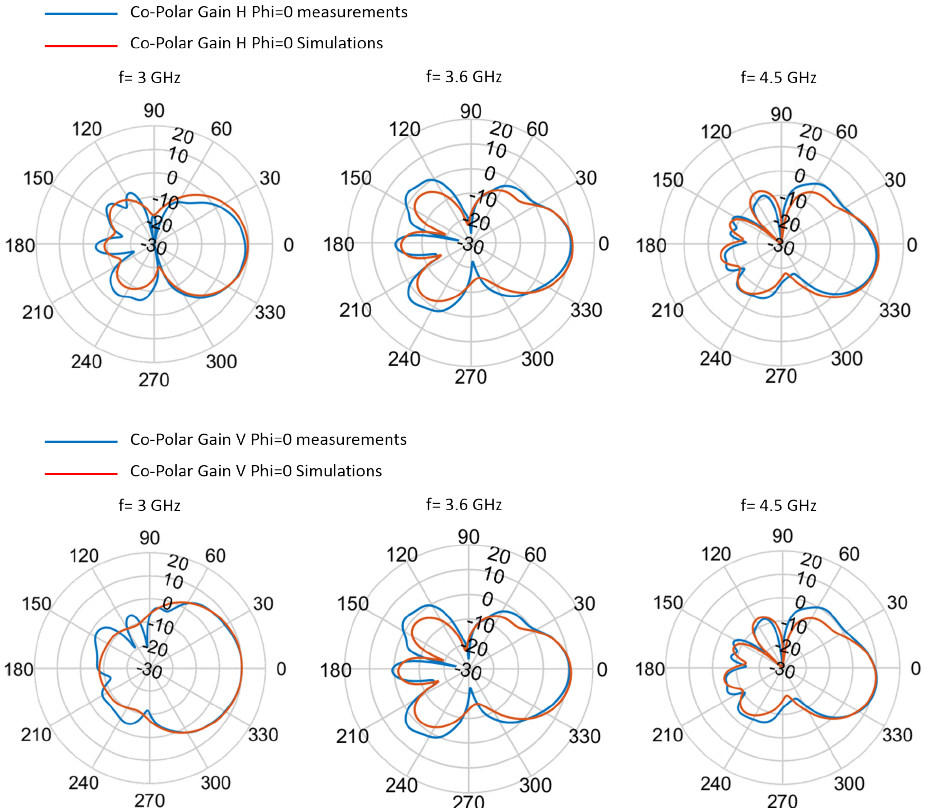
Figure 12. Scaled prototype: comparison between measurement and simulation in term of co-polar and cross-polar gain for both H/V polarizations at three different frequencies. In this case, the gain has been plotted because, in band, it is practically coincident with the realized